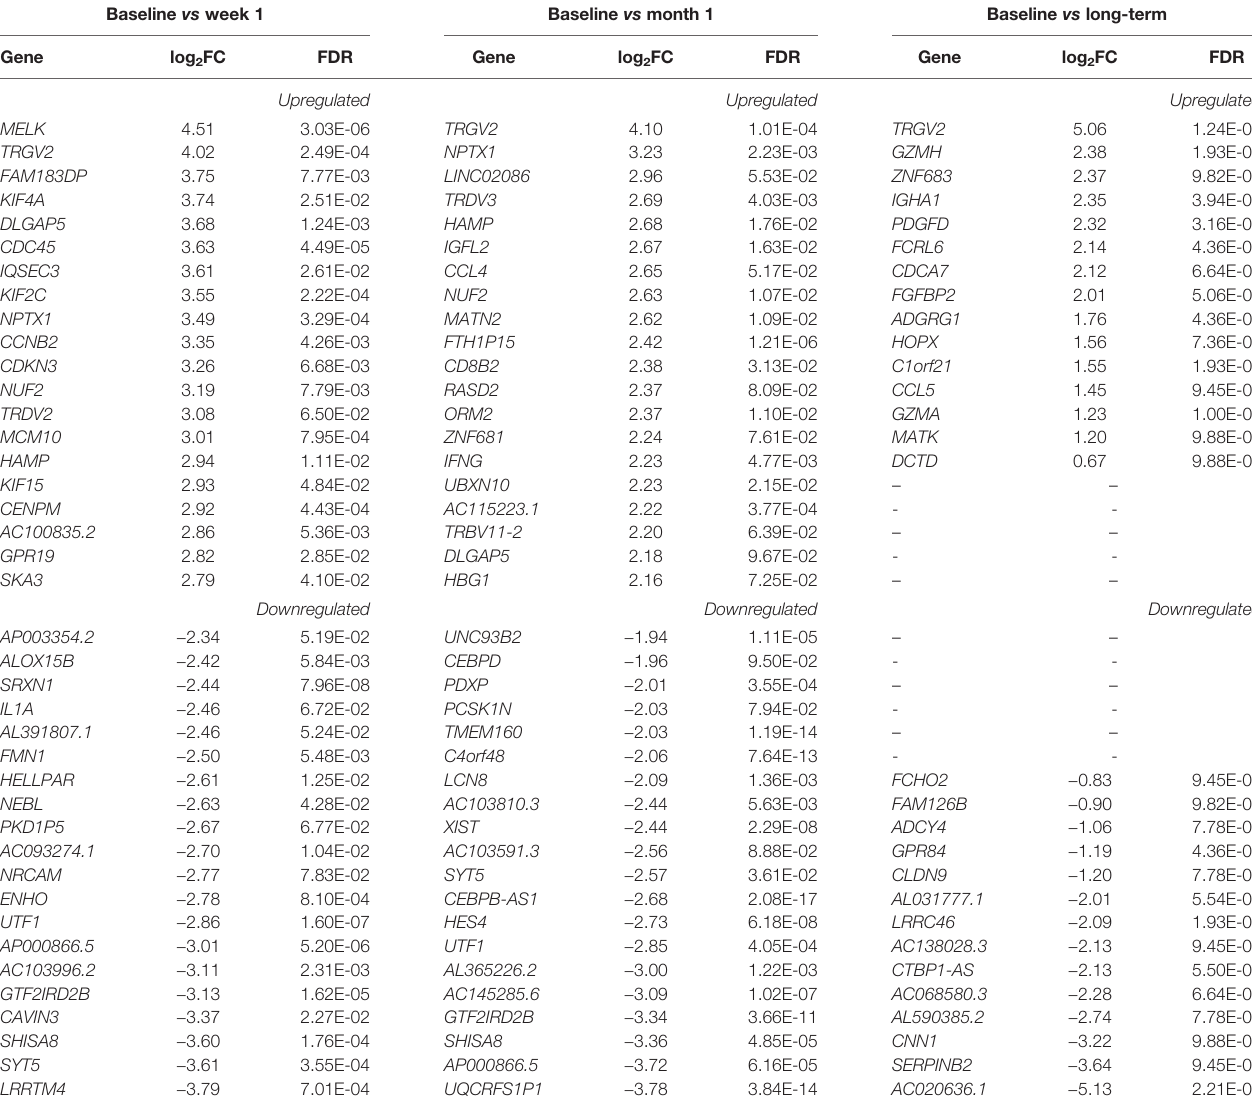
TABLE 2B | Top 20 up-/downregulated genes from each timepoint comparison for patients with DNAemia. Baseline vs week 1